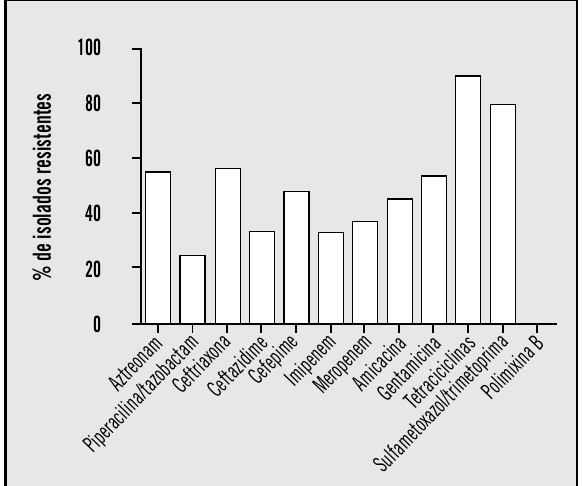
Figura – Perfil de resistência aos antimicrobianos de pacientes hospitalizados no Hospital Divina Providência em Porto